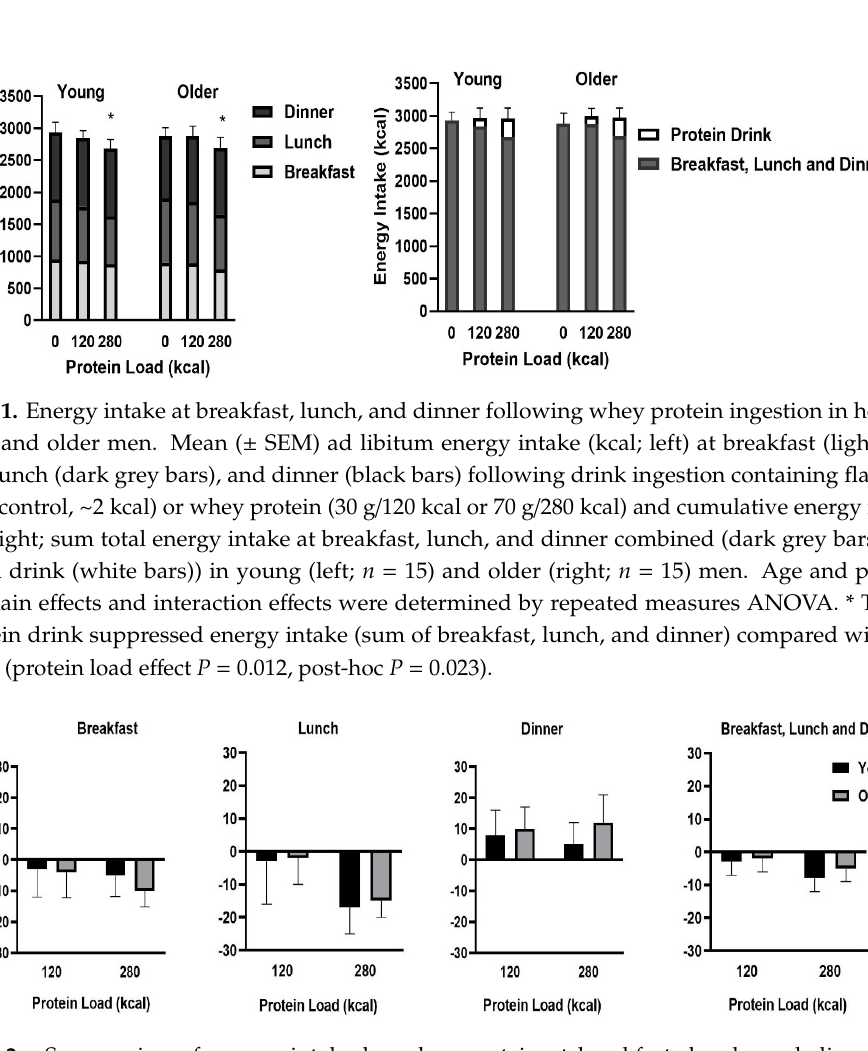
Figure 3. Mean (± SEM) protein intake (g) at breakfast (light grey bars), lunch (dark grey bars), and dinner (black bars) following drink ingestion containing flavored water (control, ~2kcal) or whey protein (30 g/120 kcal or 70 g/280 kcal; white bars) in young (left; n = 15) and older (right; n = 15) men. Age and protein load main effects and interaction effects were determined by using repeated- measures ANOVA. * Cumulative protein intake (sum of protein drink plus protein intake at meals)